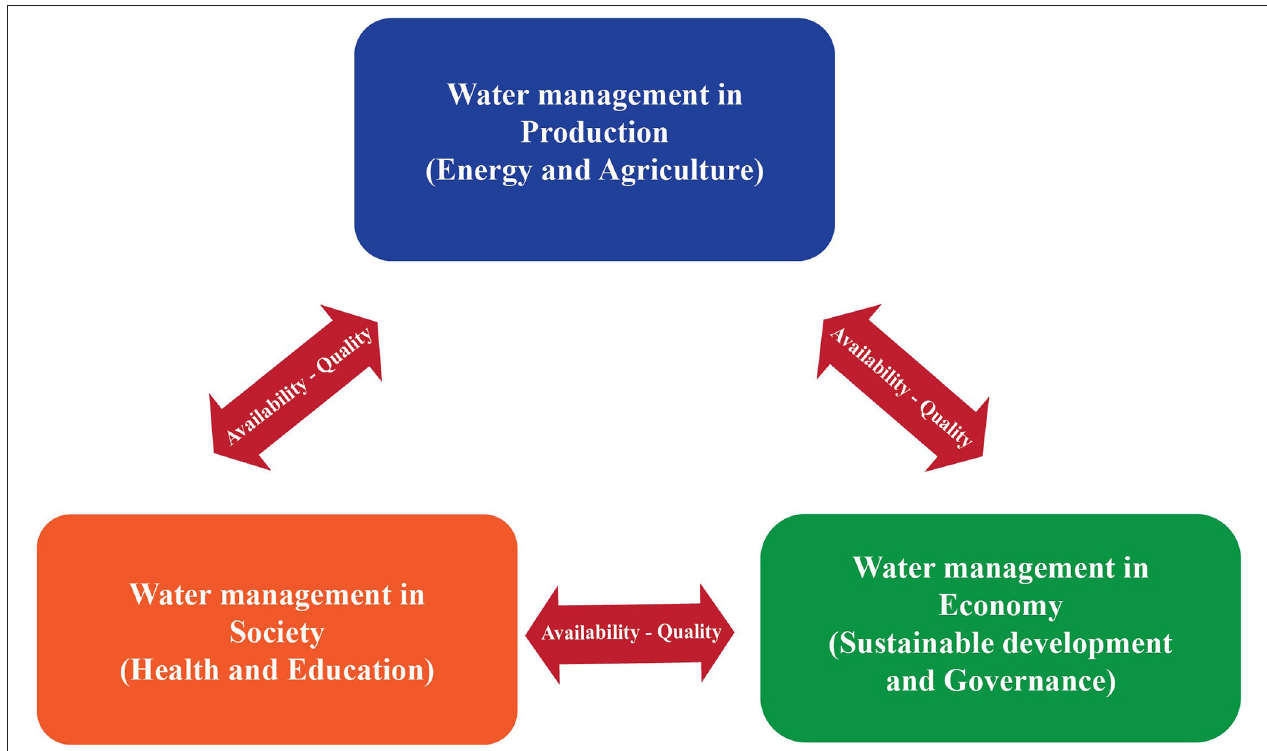
FIGURE 1 | The link of the three water management